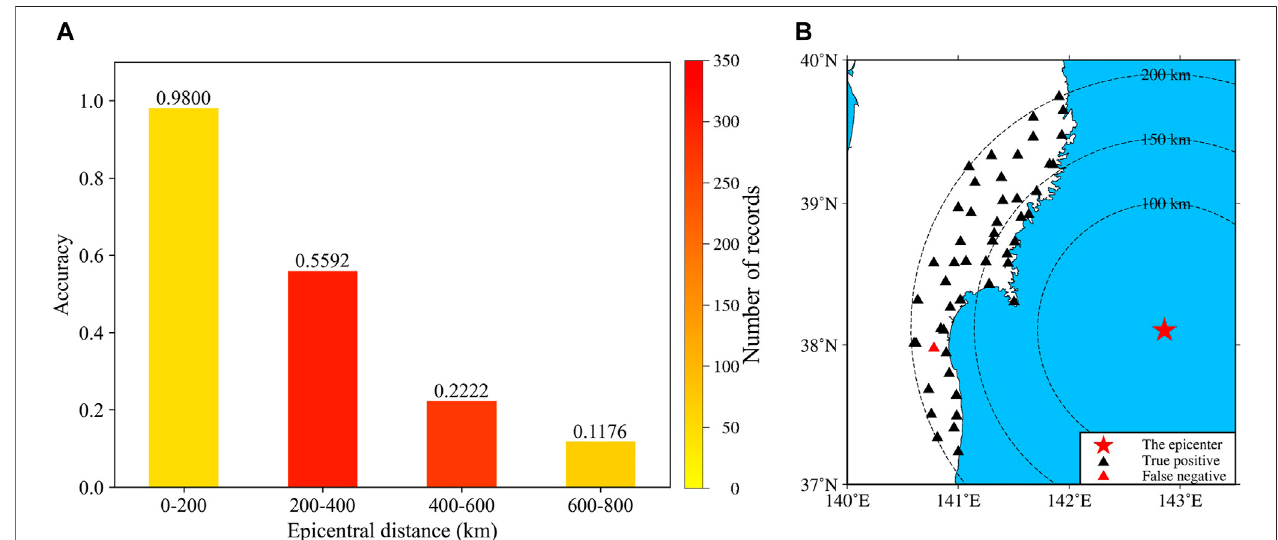
FIGURE 9 | (A) Dependence of the combined model performance on the magnitudes for the Great East Japan earthquake dataset. (B) Locations of the true positive and false negative records with epicentral distances ≤ 200 km in the Great East Japan earthquake dataset. The red star represents the epicenter, and the triangles represent the locations of the triggered stations. Black indicates a true positive, and red indicates a false